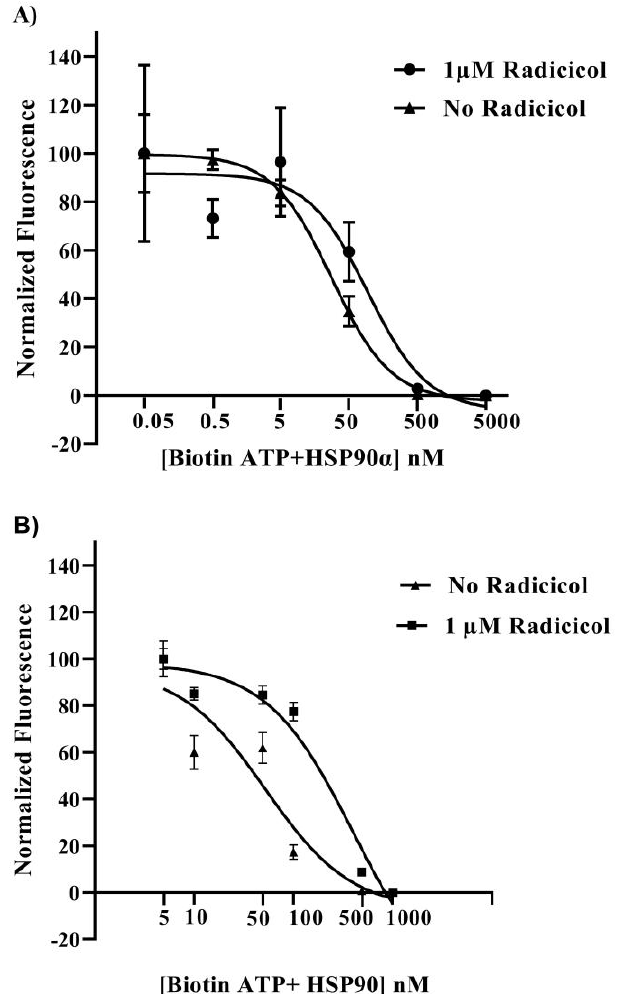
Figure 4. Concentration-dependent masking is fitted in a dose-responsive manner. Maximum fluorescence intensity is counted as 100%, which is 0.05 nM and 5 nM HSP90 α in graphs ( A , B ), respectively. The concentration of the Sav-QDs was 100 nM. In graph ( A ), masking of Sav-QDs was achieved as a function of biotin-ATP which was kept constant at 500 nM and varying only HSP90 α concentration with and without radicicol. IC 50 value of the graph with 1 µ M of radicicol is 92.06 nM and without radicicol is 27.27 nM. Additionally, in graph( B ), there is a varying Hsp90 α concentration with ten times the streptavidin concentration with and without radicicol. IC 50 values of graphs with radicicol is 396.7 nM and without radicicol is 52.21 nM. Parameters of the dose–response fitting for graph ( A ), A1 = 0.05, A2 = 5000, p = 1 log X = 1.964 (1 µ M of radicicol), 1.436 (no radicicol) X = 92.06 (1 µ M of radicicol), 27.27 (no radicicol). Parameters of the dose–response fitting for graph ( B ), A1 = 5, A2 = 1000, p = 1 log X = 2.598 (1 µ M of radicicol), 1.718 (no radicicol), X = 396.7 (1 µ M of